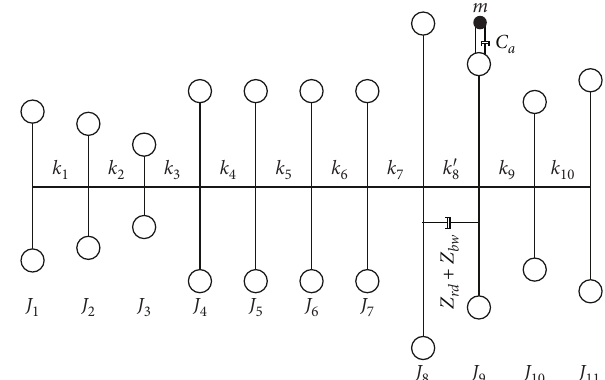
Figure 5: Torsional vibration model of power transmission under the driving